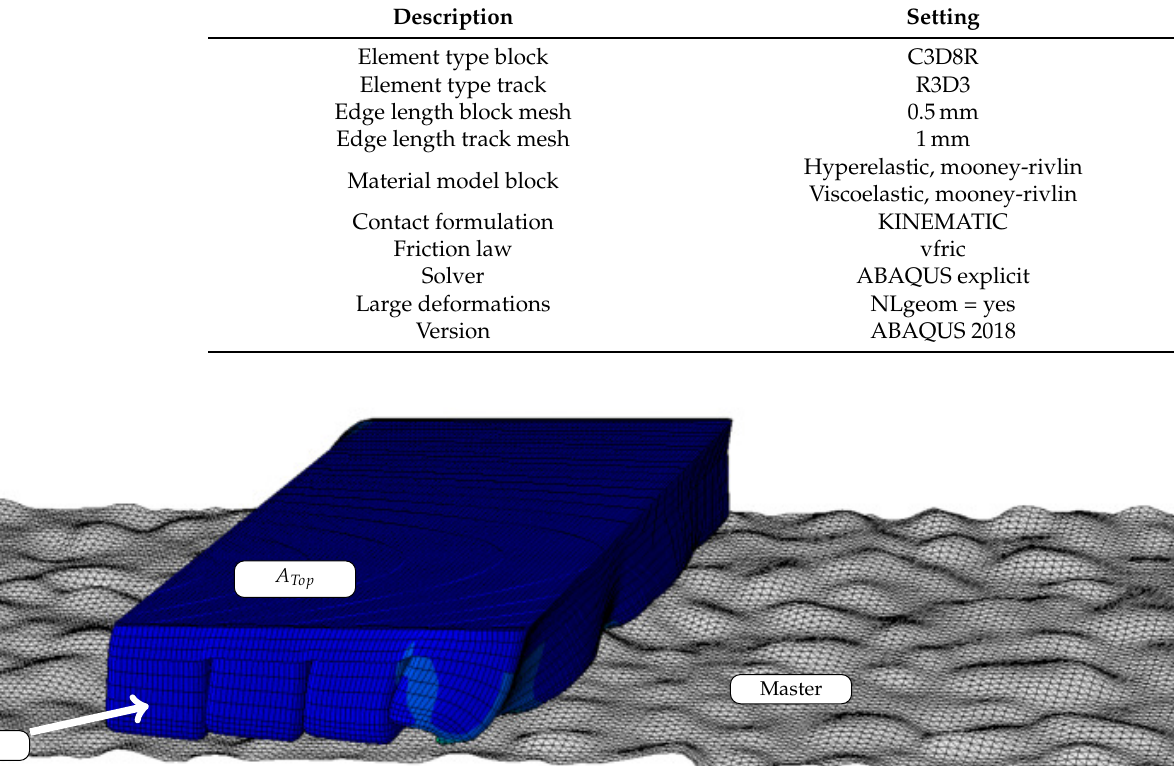
Table 1. Overview of the most important settings in A BAQUS .